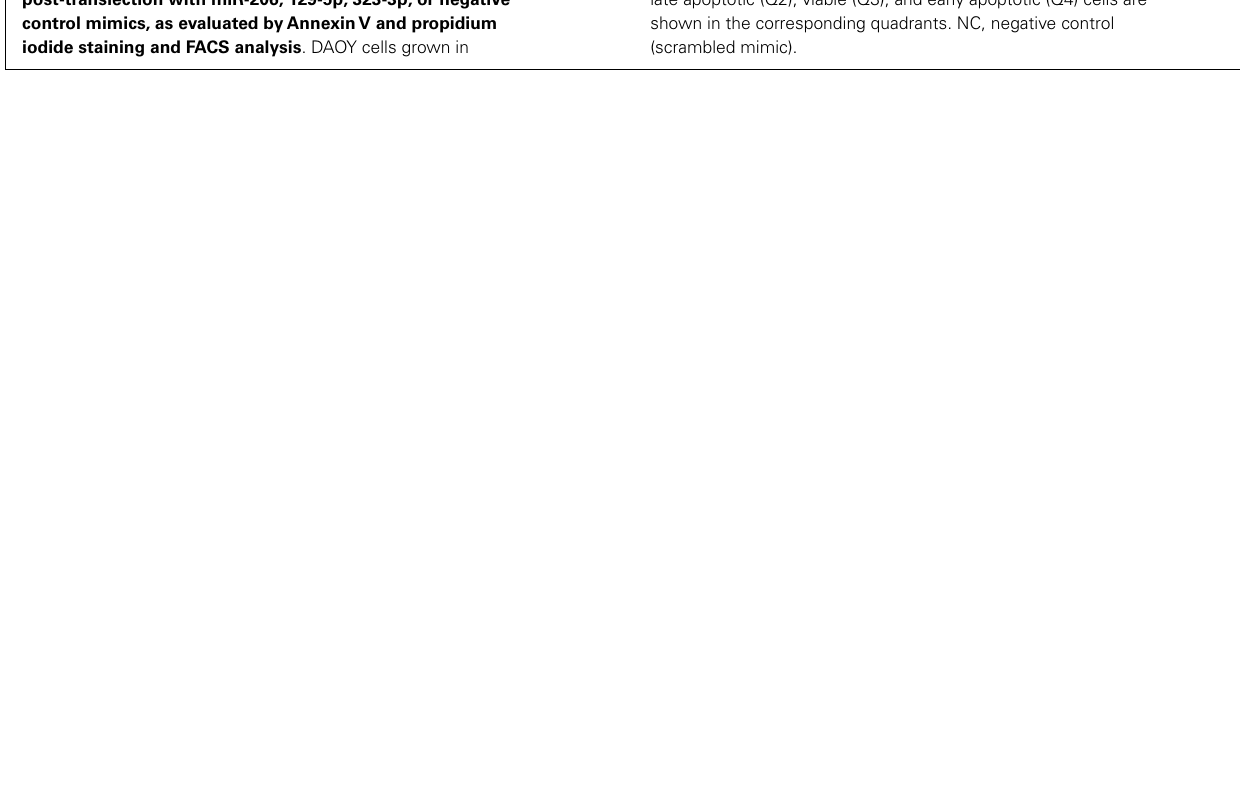
serum-free RPMI-1640 medium.The percentage of necrotic (Q1), late apoptotic (Q2), viable (Q3), and early apoptotic (Q4) cells are shown in the corresponding quadrants. NC, negative control (scrambled